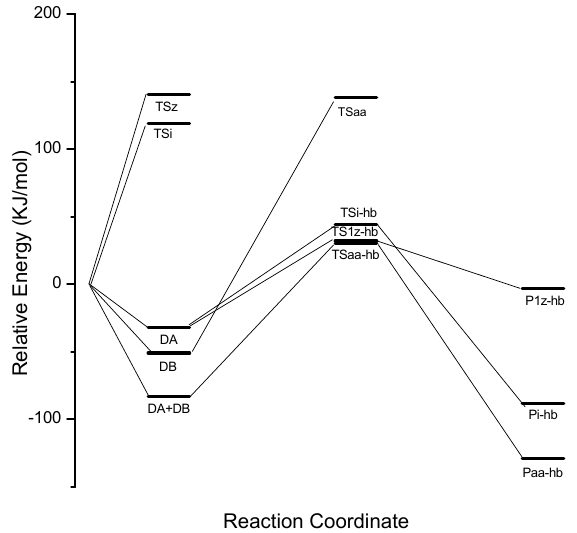
Figure 5. Potential energy diagram for the catalyzed epoxy-acrylic acid system.